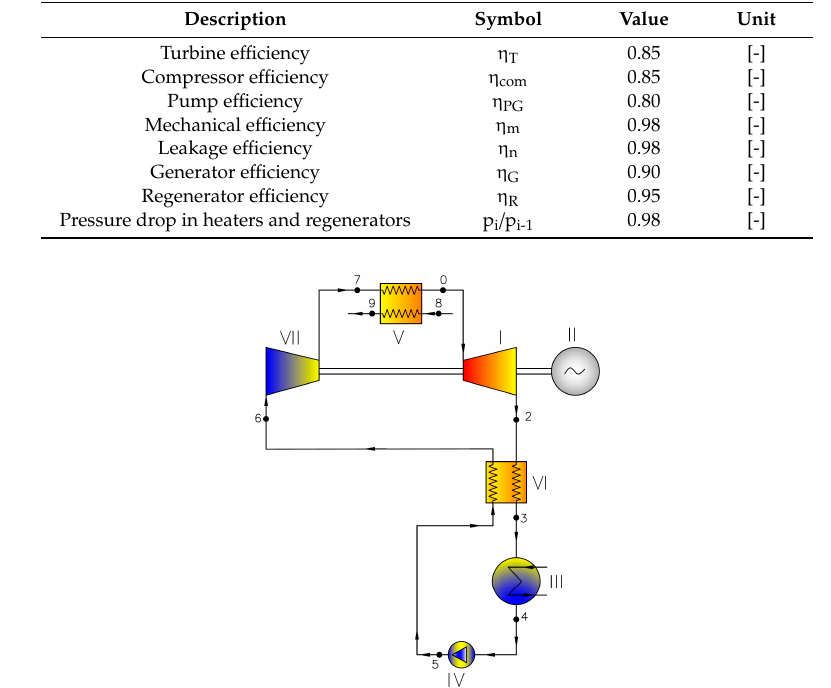
Figure 5. ORC cycle with regenerator, compressor, reheater and interstage superheater; where: Ia, Ib—turbines, II—generator, III—condenser, IV-pump, V—vapor generators, Va—interstage superheater, VI—regenerator, VII—compressor, VIII—heat exchanger (Variant 7).